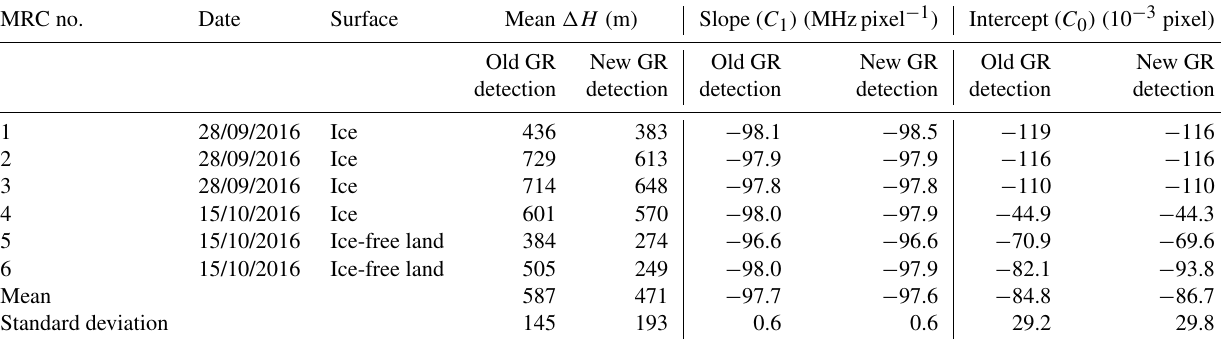
Table 3. Mie response calibration parameters obtained from the six calibrations performed on 28 September and on 15 October 2016. The zero- and first-order fitting parameters C 0 and C 1 were derived involving the old ground and new ground (GR) detection method (see text). The atmospheric contribution (cid:49)H (see Fig. 3) has been averaged over the respective calibration period. Calibration 1 was performed using a different alignment of the lidar system and is thus excluded from the statistical calculations. MRC